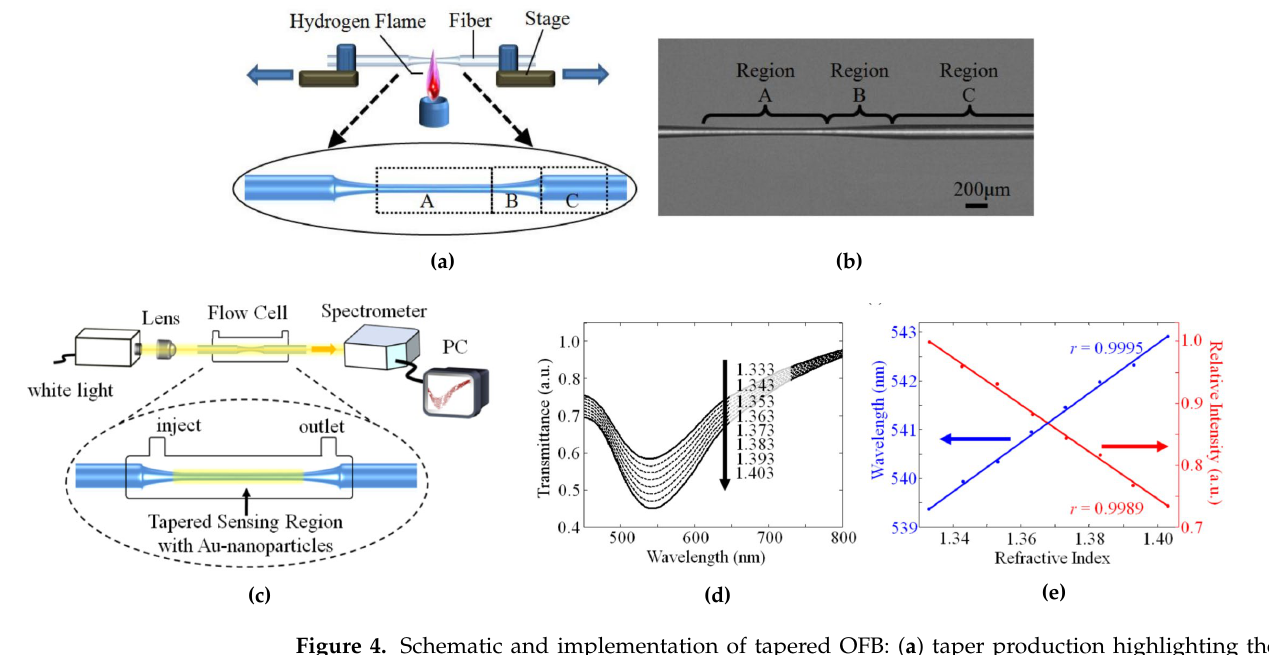
Figure 4. Schematic and implementation of tapered OFB: ( a ) taper production highlighting the respective fiber taper regions and ( b ) optical microscopy image of the tapered fiber showing the three regions; ( c ) taper coated with Au NPs and respective interrogation scheme, and ( d ) results showing the variation in wavelength and transmittance with RI variation with respective linear fittings ( e ) (images reproduced from [39]).